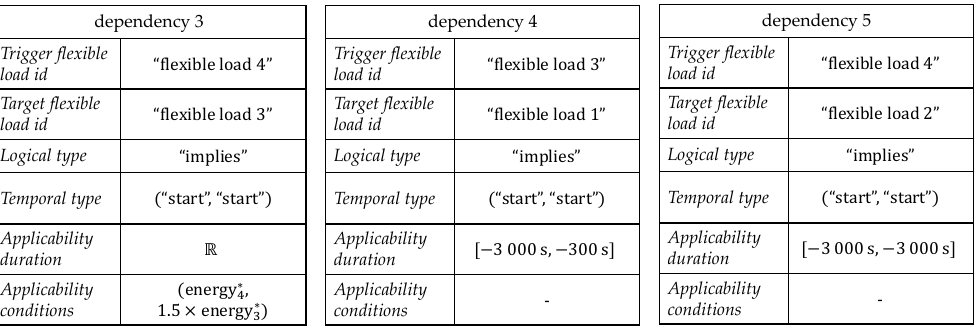
Figure 9. Additional dependencies for flexible loads 1 to